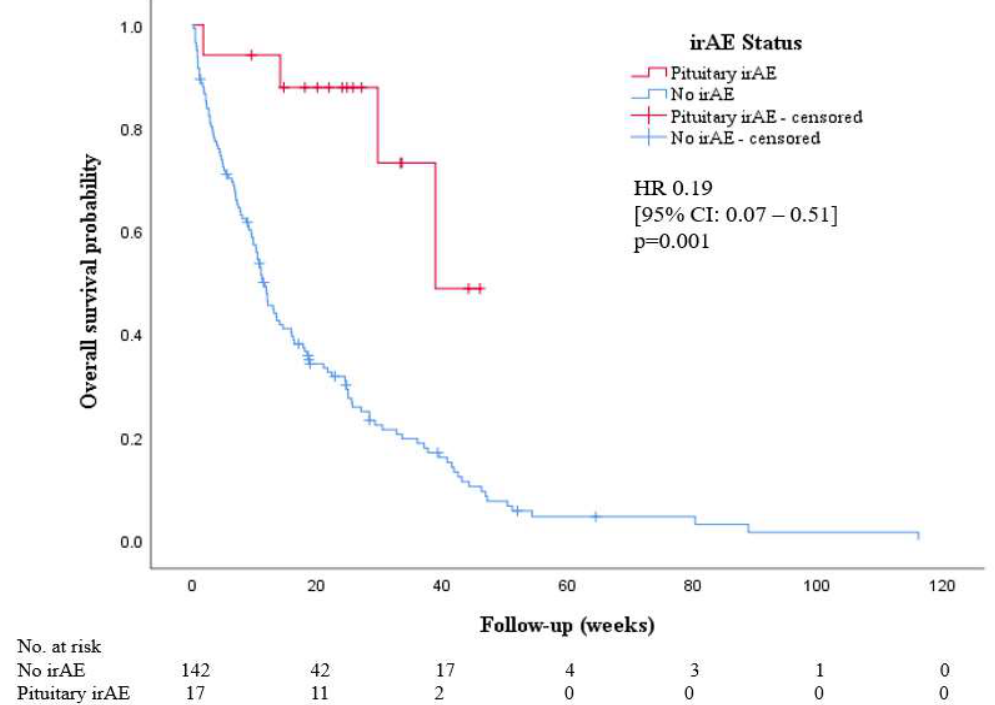
Figure 4. Kaplan–Meier curves for overall survival according to pituitary irAE status .